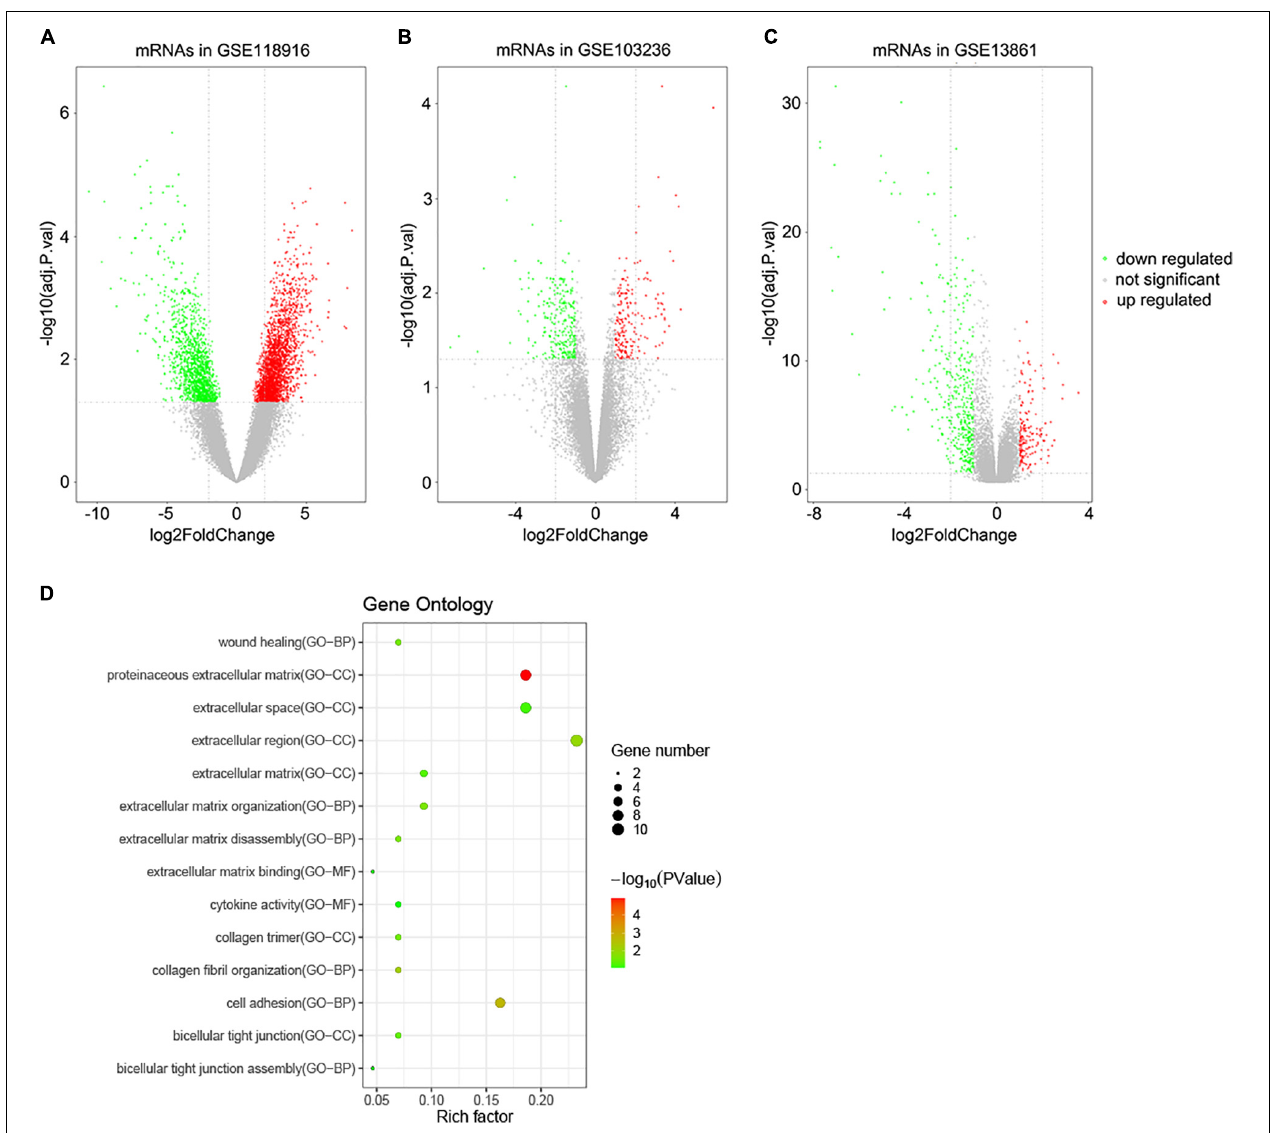
FIGURE 1 | Volcano plots of DEGs in the three GEO datasets and functional enrichment of DEGs. (A) DEGs of the GSE118916 dataset. (B) DEGs of the GSE103036 dataset. (C) DEGs of the GSE13861 dataset. (D) Statistics of functional enrichment. CC represents cellular component, MF represents molecular function, and BP represents biological